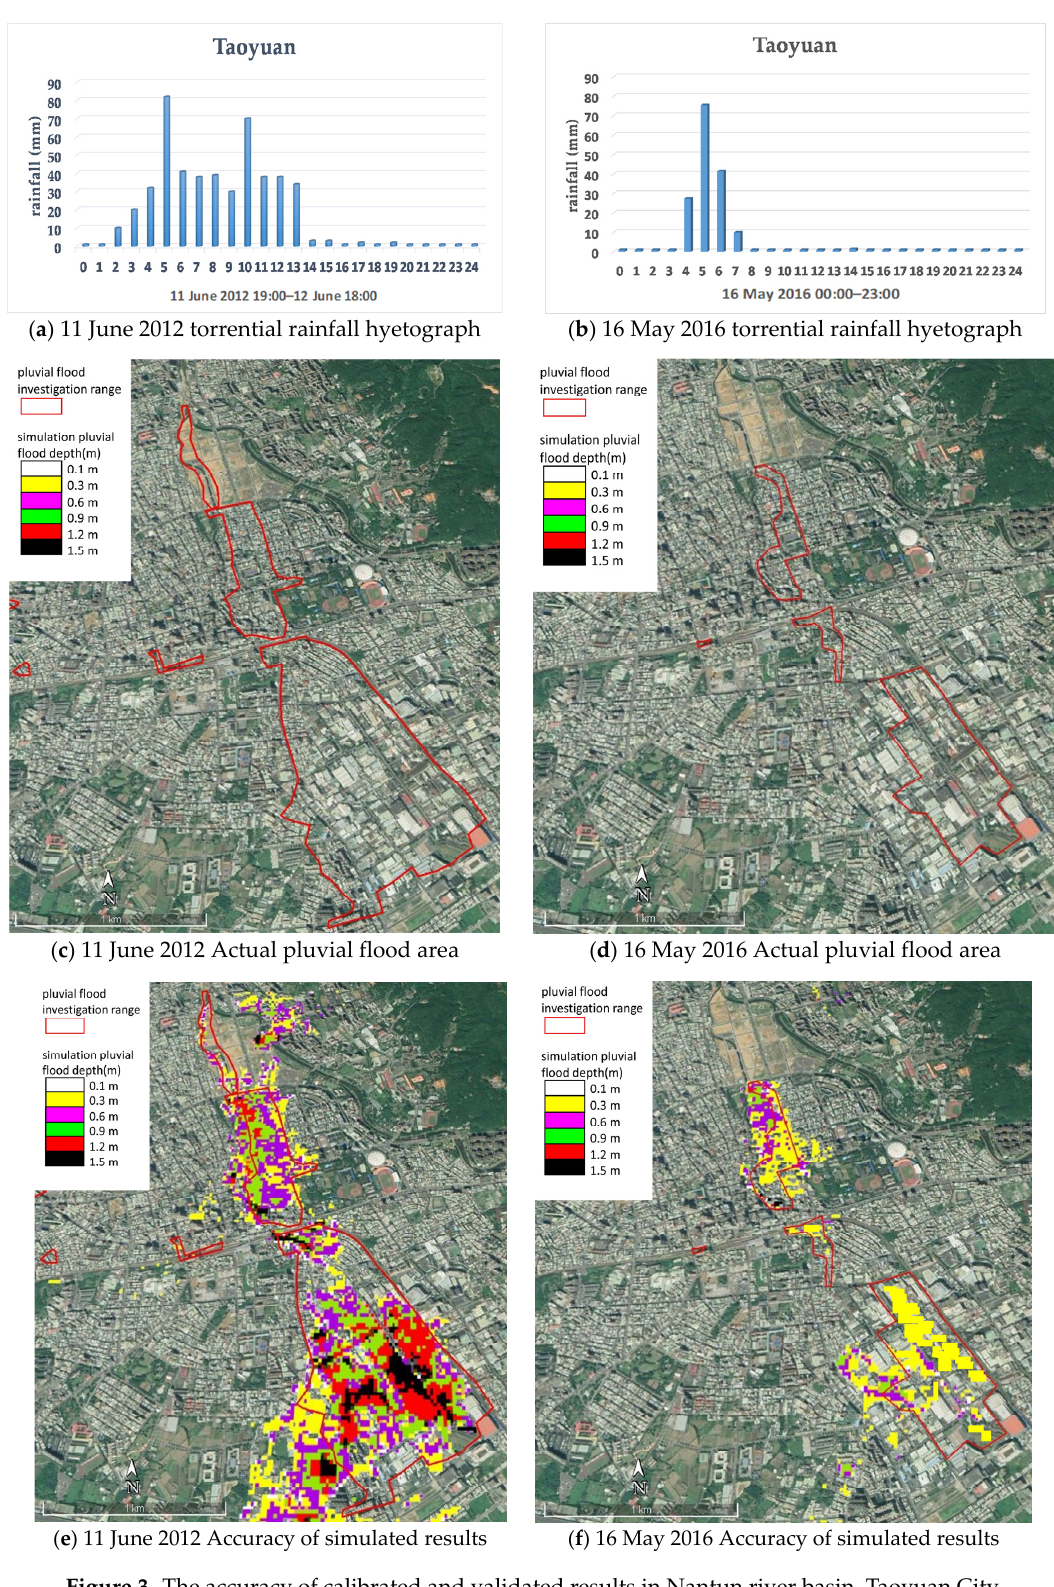
Figure 3. The accuracy of calibrated and validated results in Nantun river basin, Taoyuan City.